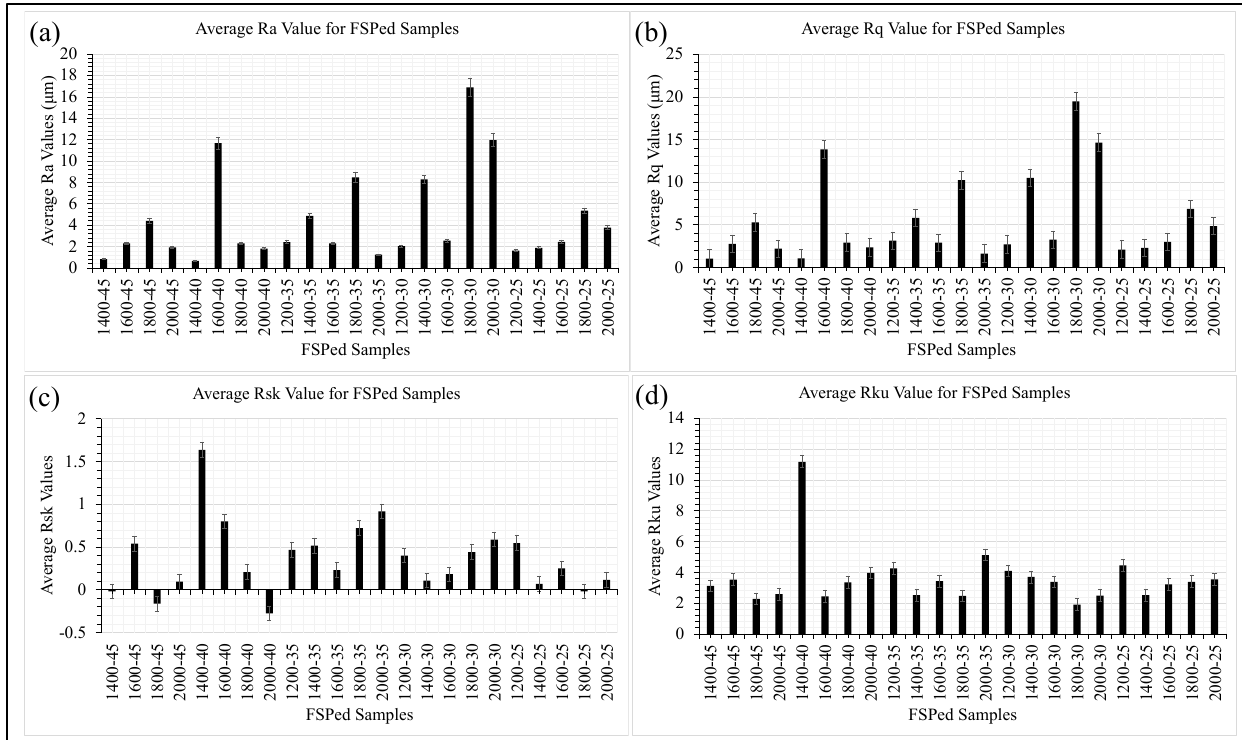
Figure 10. FSPed surface roughness, ( a ) average R a , ( b ) R q , ( c ) R sk , and ( d ) R ku values.